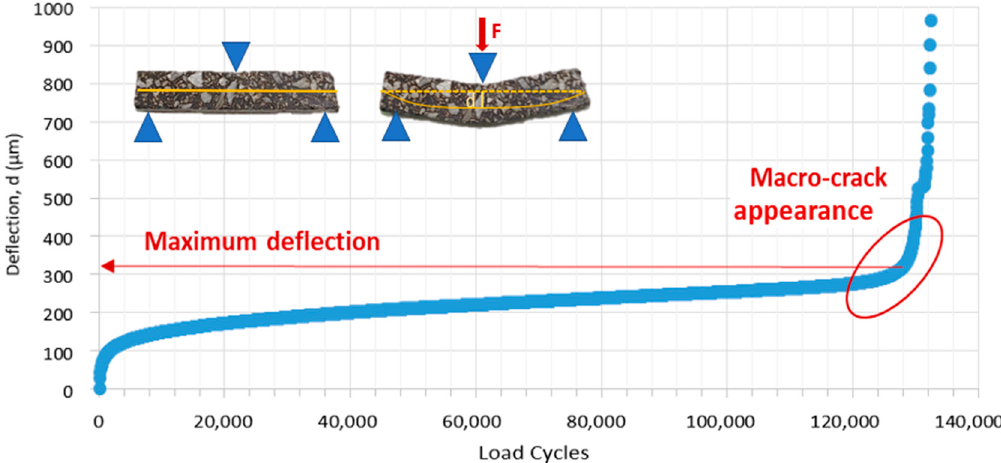
Figure 5. Deflection (d) registered during 3-point bending fatigue tests.